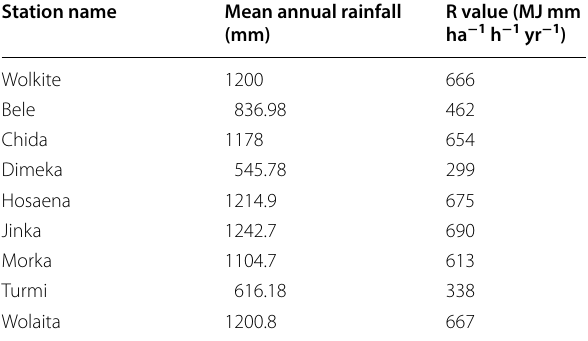
Table 2 Mean annual rainfall and R value of each stations Station name